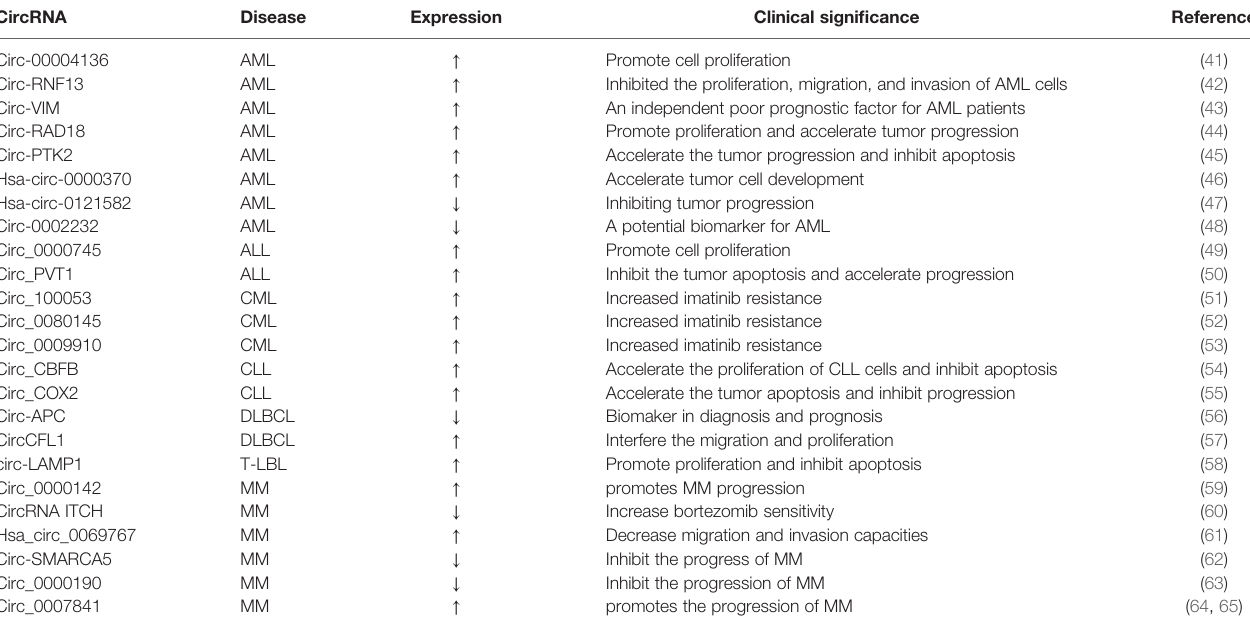
TABLE 1 | Some abnormal circRNAs with con fi rmed functions in the universal category of hematological malignancies ( ↑ : up-regulated; ↓ :down-regulated). CircRNA Disease